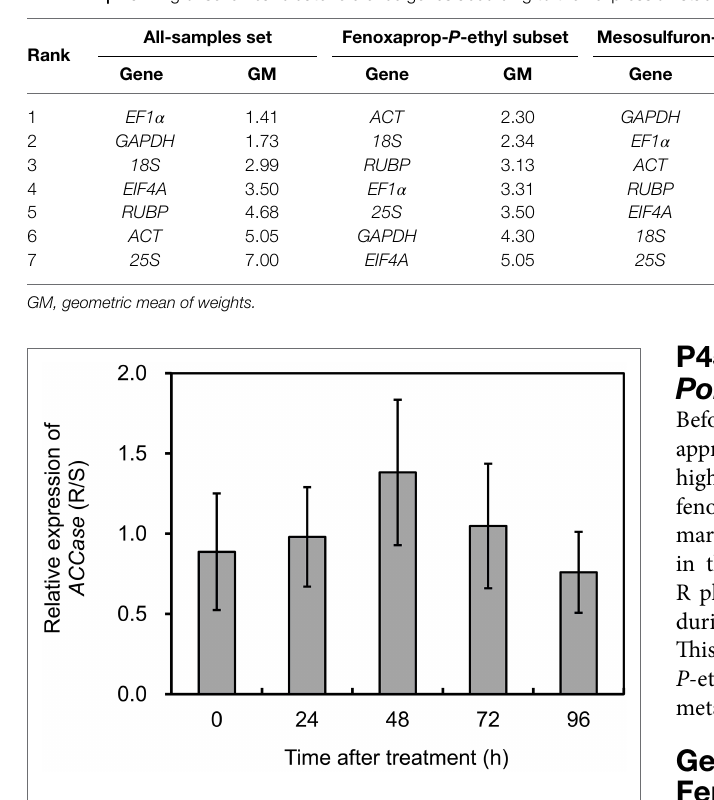
TABLE 2 | Ranking of seven candidate reference genes according to their expression stability using RefFinder.